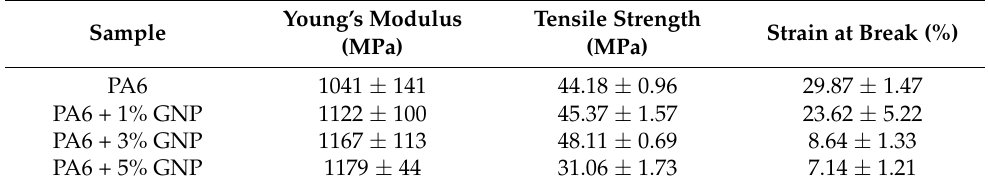
Table 3. Tensile